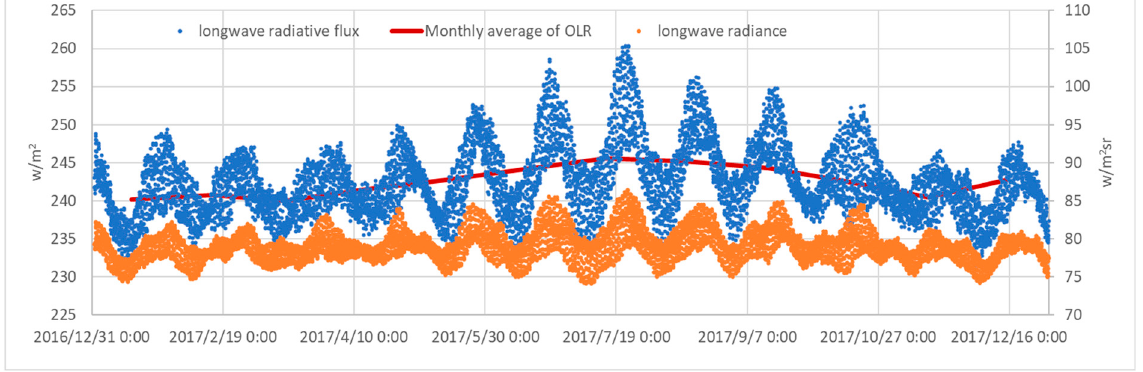
Figure 10. The time series of simulated global mean TOA OLR flux, the global mean longwave radiance in the Moon-based view, and the monthly mean of global TOA OLR flux.